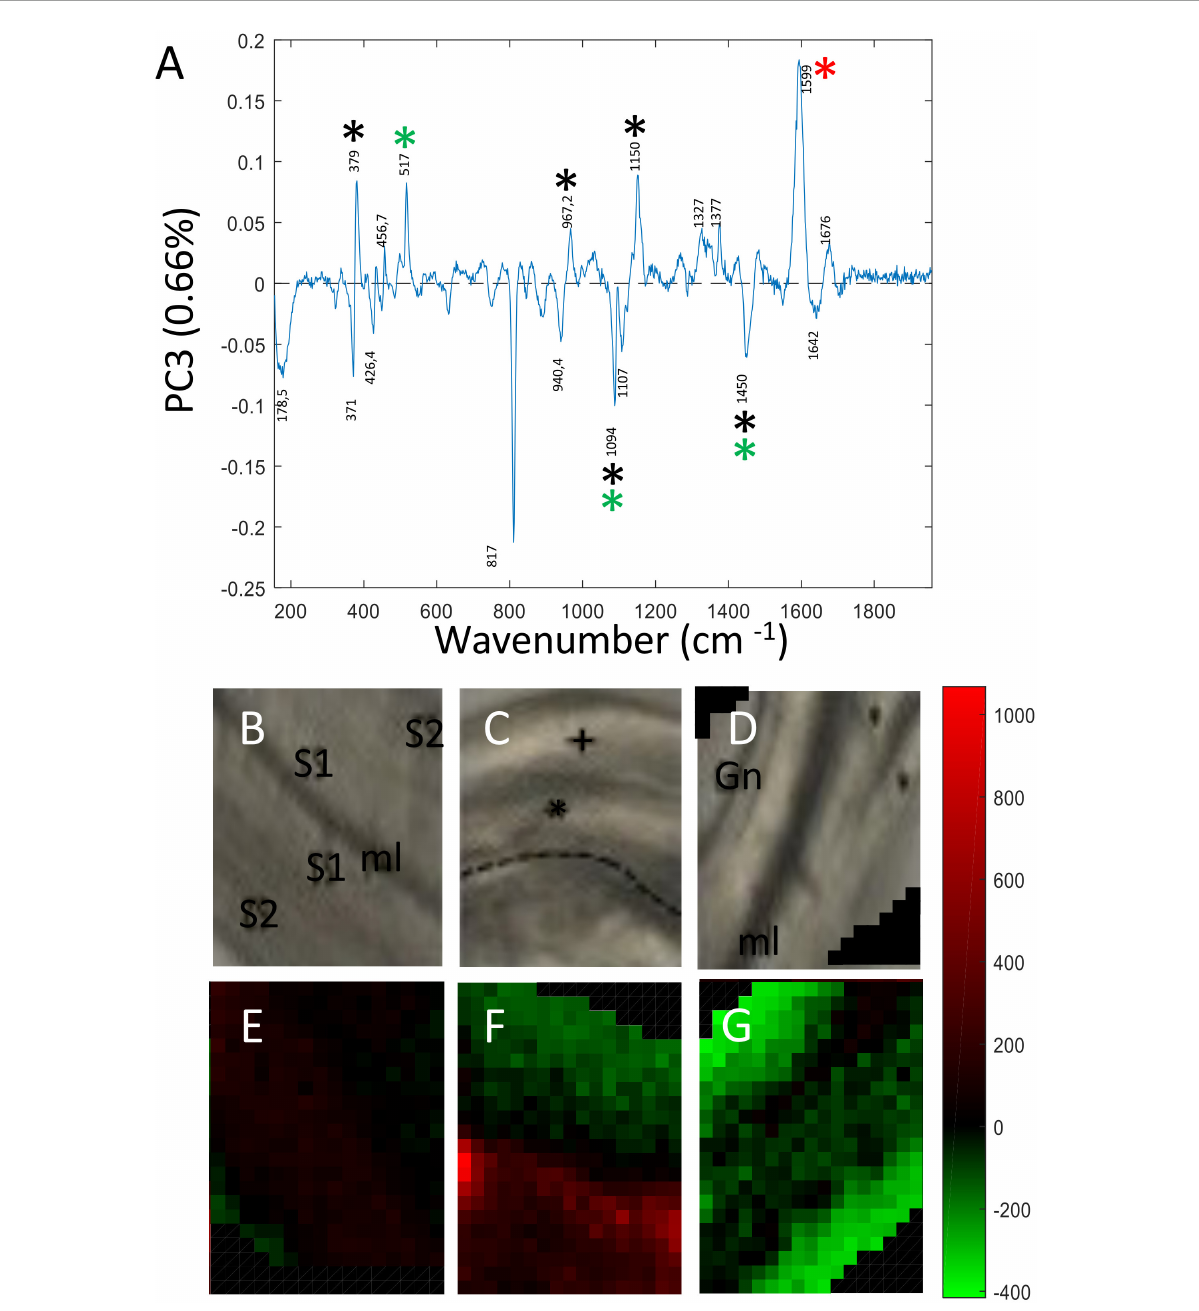
FIGURE5 PC score imaging of PC3 (0.66%). (A) Loading vector of PC3. Peaks making positive contributions concerned chemical bonds related to cellulose (379; 1,150 cm − 1 ), xyloglucan (517 cm − 1 ), and lignin/aromatics (1,599 cm − 1 ). Negative contribution concerned cellulose/xyloglucan peaks (1,094; 1,452 cm − 1 ) Only major contributions (positive or negative) are considered. Black asterisk: cellulose, Red asterisk: lignin, Green asterisk: xylan and xyloglucan. Blue asterisk: pectin. (B,E) Bast fibers control. (C,F) Bast fibers from the pulling side. (D,G) Bast fiber from the opposite side. The 817 cm − 1 peak (negative contribution) was really ambiguous to assign to a particular polymer and was not considered as reliable.